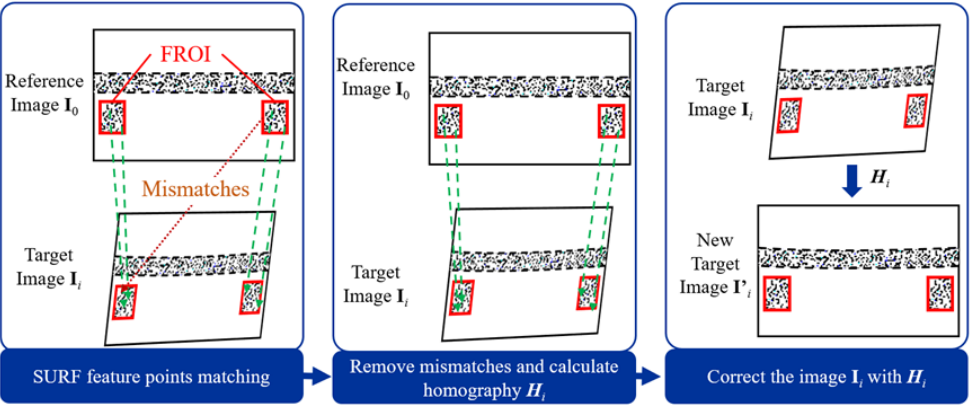
Figure 4. Feature points searching using the SURF and MSAC